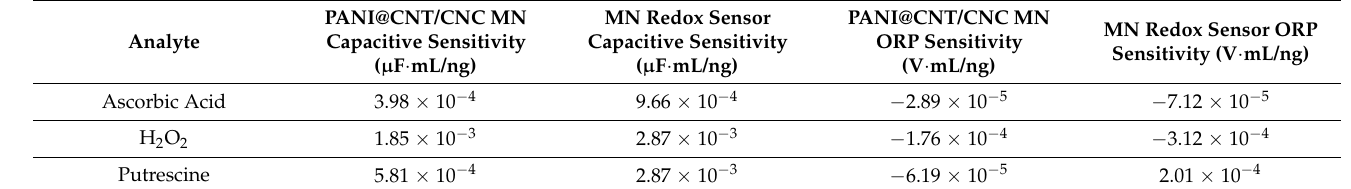
Table 2 outlines the various concentration ranges and LODs of various electrochemical sensors for the analytes under analysis. Despite the linear detection range of the MN redox sensor being narrower, the lower limit of the detection range is less than several reported electrochemical sensors (Table 2), making low-concentration measurements more accurate. Moreover, the LODs of each analyte are either lower, or comparable to some of the reported sensors (Table 2). While conventional chromatographic techniques, may yield highly accurate results, low LODs, and wider detection ranges (Table 2), their operation is tedious and non-amenable to rapid antioxidant determination [17,32]. Conversely, the MN redox sensor is portable, reusable, takes rapid measurements, and is capable of in situ analysis of food and drink samples. While the MN redox sensor has several advantages, it is limited in availability due to the requirement of a needle infuser pump to fabricate. Table 1. Capacitive and ORP sensitivities for the PANI@CNT/CNC microneedle (MN) and MN redox sensor in response to ascorbic acid, H 2 O 2 , and putrescine analytes.